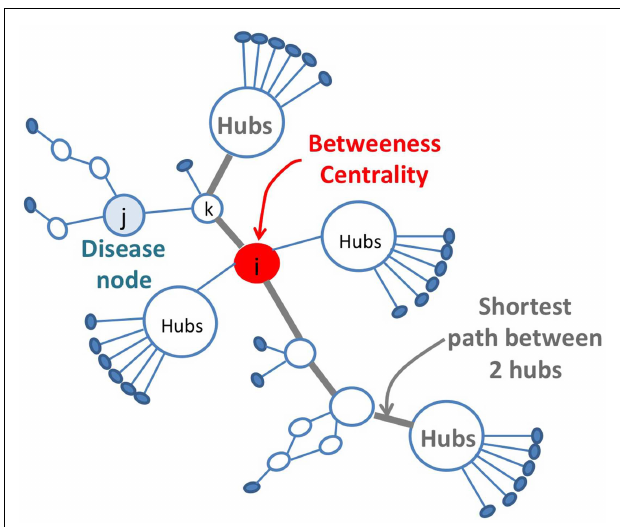
FIGURE 2 | Selection of protein candidates for pharmaceutical synergy . The selection of source proteins that are potential candidates for pharmaceutical synergy is based on topological properties, favoring the in-between nodes with respect to hubs. Hubs proteins are highly connected nodes that tend to be more essential than non-hub proteins but targeting them might produce a large number of side effects.The drug combination strategy consists of targeting less important proteins to have less impact on the overall system alone while maintaining drug efficacy thanks to the synergistic effect on several points of the biological network. These secondary proteins correspond to in-between nodes in the network. They are identified using bridging centrality index that is computed as the product of its betweenness centrality and a bridging coefficient that evaluates if a node is located between high degree nodes ( Table 1